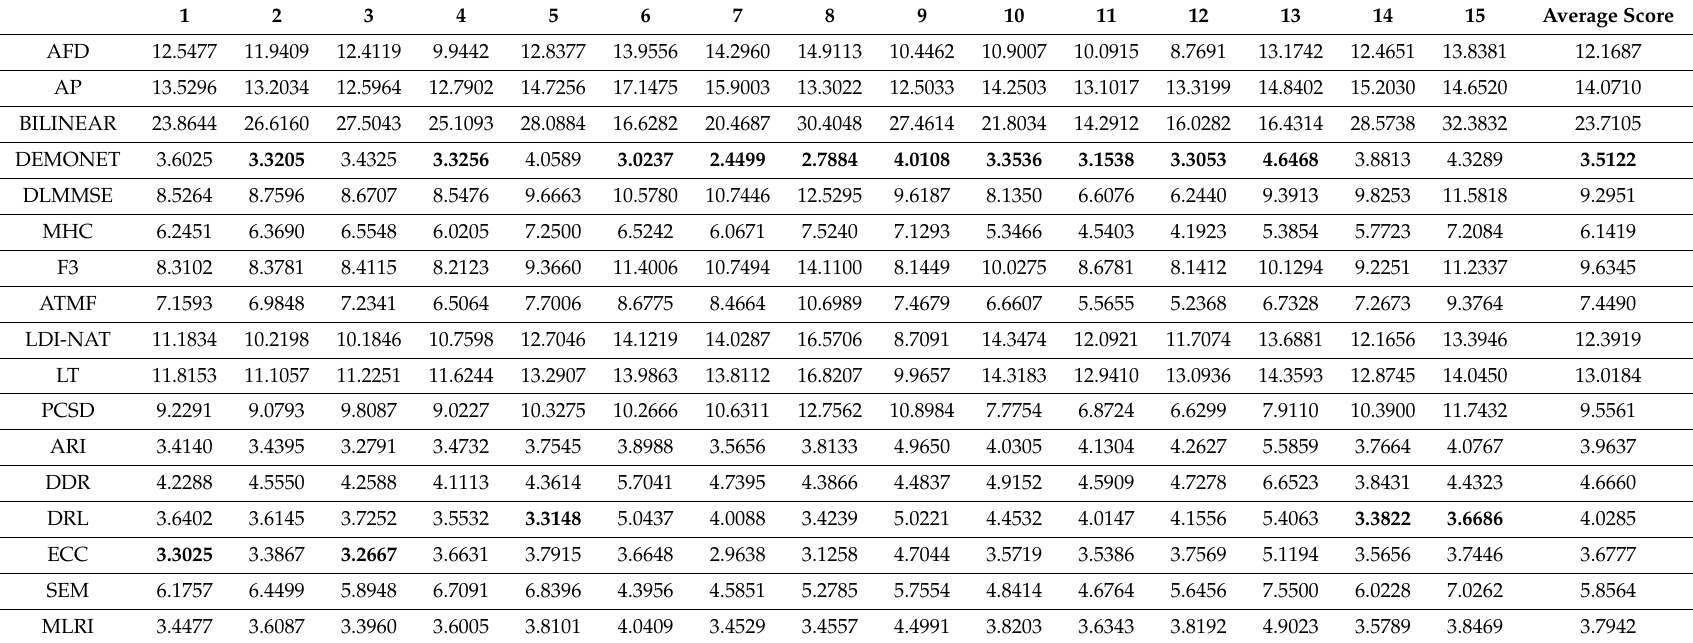
Table 7. Summary of NIQE scores (lower = better). Fifteen right images: Blue